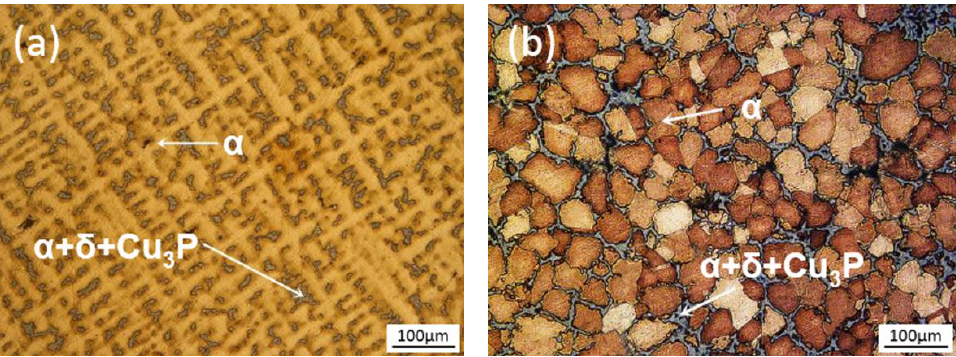
Figure 4. Microstructures of ZCuSn10P1 alloy: ( a ) as-cast; and ( b ) semi-solid.